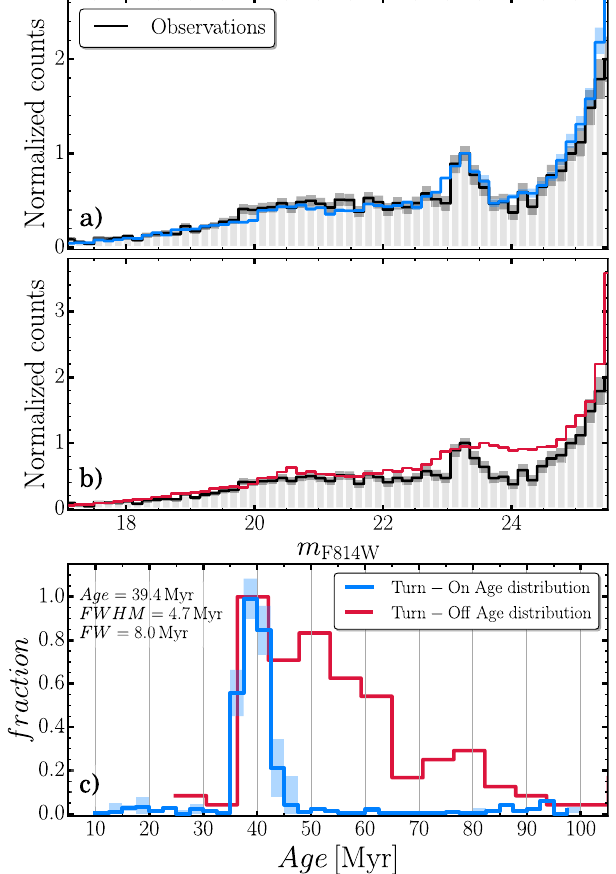
Fig. 4 | The Luminosity Function of NGC1818 and its age distribution. a Observed Luminosity Function of main-sequence stars of NGC1818 is shown in solid black, while the uncertainties are indicated by the dark-grey shaded regions. The blue line corresponds to the best- fi t LF, with uncertainties indicated by the azure-shadedregions. b Asin( a ),the black line indicates the observed LF,whereas the red line represents the LF inferred from the age distribution inferred from the eMSTO(panelcofFig.2).They-axisof( a )and( b )havebeennormalizedsothatthe height of the turn-on peak corresponds to 1. c Age distributions of NGC1818 inferred from the turn-off (red) and the turn-on (blue). The shaded regions repre- sent the inferred uncertainties. The top-left inset shows the mean, FWHM and full width, in Myr, of the least-square best fi t Gaussian function.